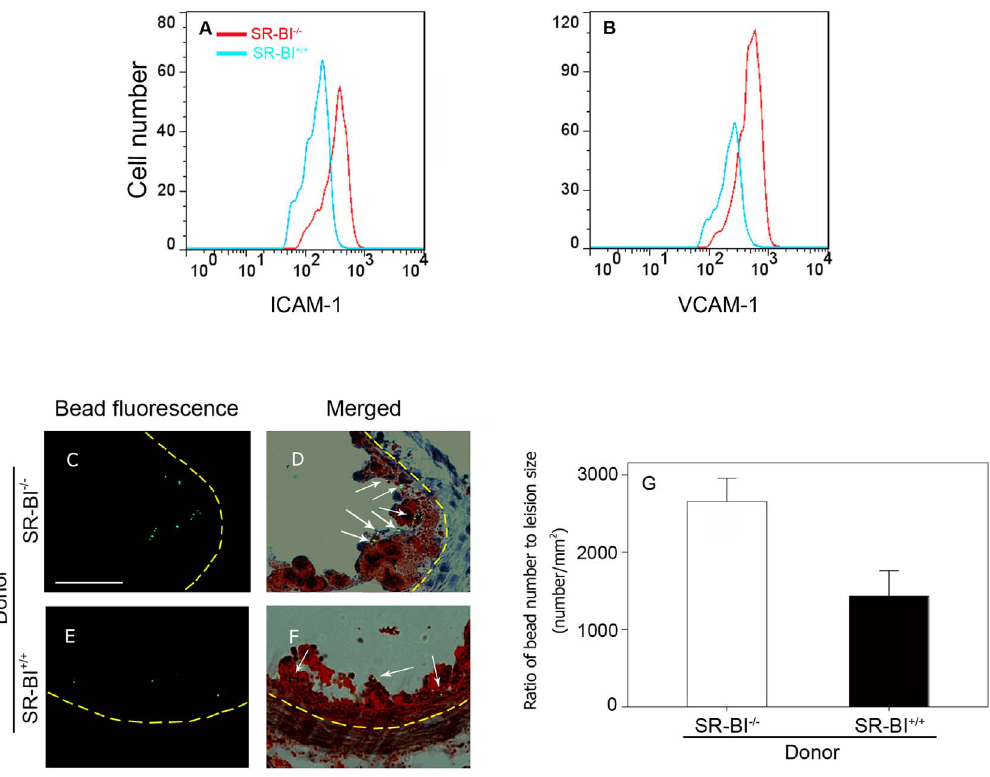
Figure 6. SR-BI attenuates monocyte recruitment . A. ICAM-1 binding, B. VCAM-1 binding, by monocytes from SR-BI + / + apoE-hypomorphic (blue) or SR-BI 2 / 2 apoE-hypomorphic mice (red) as determined by flow cytometry. Representative histograms of 4 replicates are shown. C – G : In vivo recruitment of latex bead marked monocytes into atherosclerotic plaques. Fluorescence images in dark-field (C and E) or overlayed onto brightfield images (D and F) of oil red O stained aortic sinus atherosclerotic plaques from SR-BI 2 / 2 R SR-BI 2 / 2 (C, D) and SR-BI + / + R SR-BI 2 / 2 mice (E, F). Arrows in D and F indicate the positions of green fluorescent latex bead marked cells. Scale bar = 50 m m. G. Quantification of fluorescent bead marked cells in atherosclerotic plaques (normalized to plaque sizes). Data are averages 6 standard errors. N=4 mice per group. P=0.039 by Student’s T test.